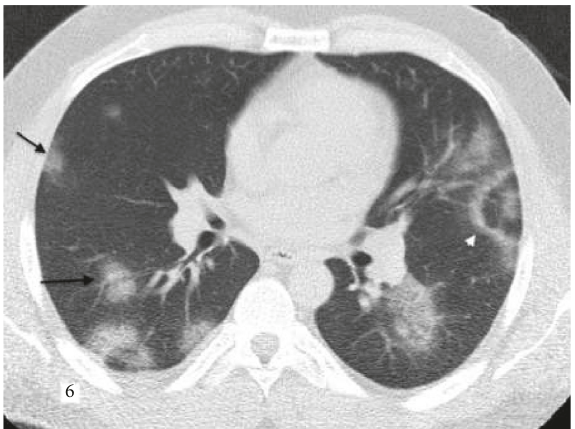
Figure 6: A 32-year-old male patient with COVID-19 pneumonia with a known diagnosis of asthma. Typical presentation according to RSNA guidelines, CORADS score given as 5. Bilateral lung parenchyma rounded, multifocal GGO lesions (black arrows), reversed halo sign (white arrow) center is relatively normal, with GGO in the